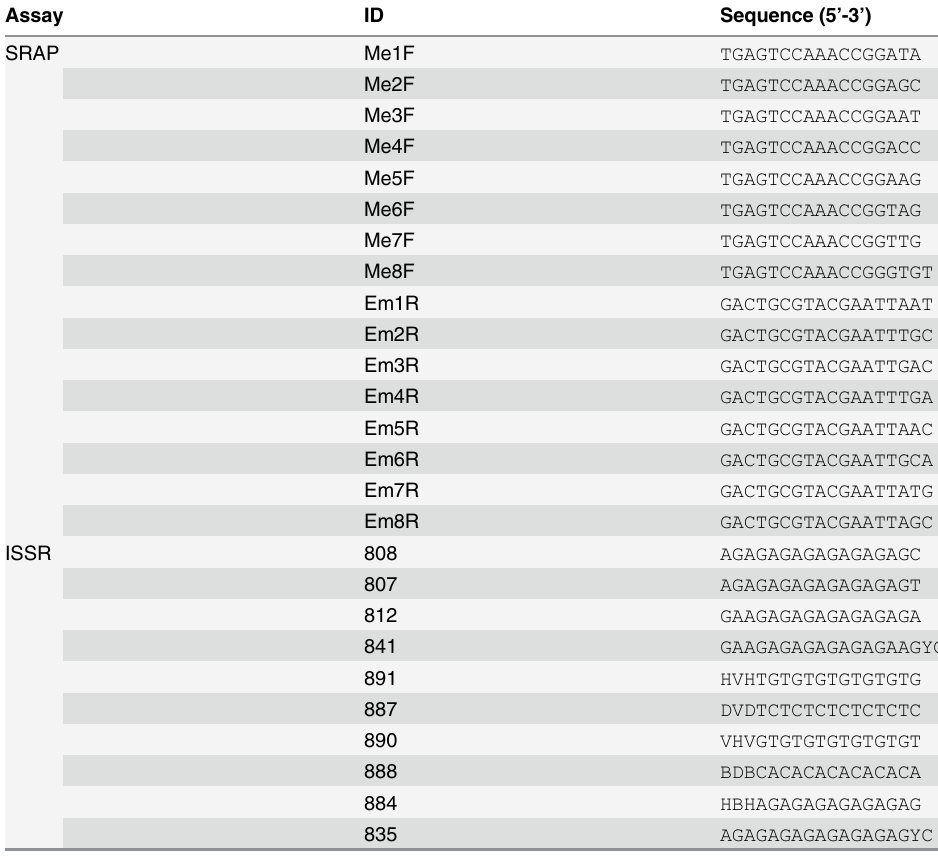
Table 2. Primers used for SRAP and ISSR analysis in this study. Assay ID Sequence (5 ’ -3 ’ ) SRAP Me1F